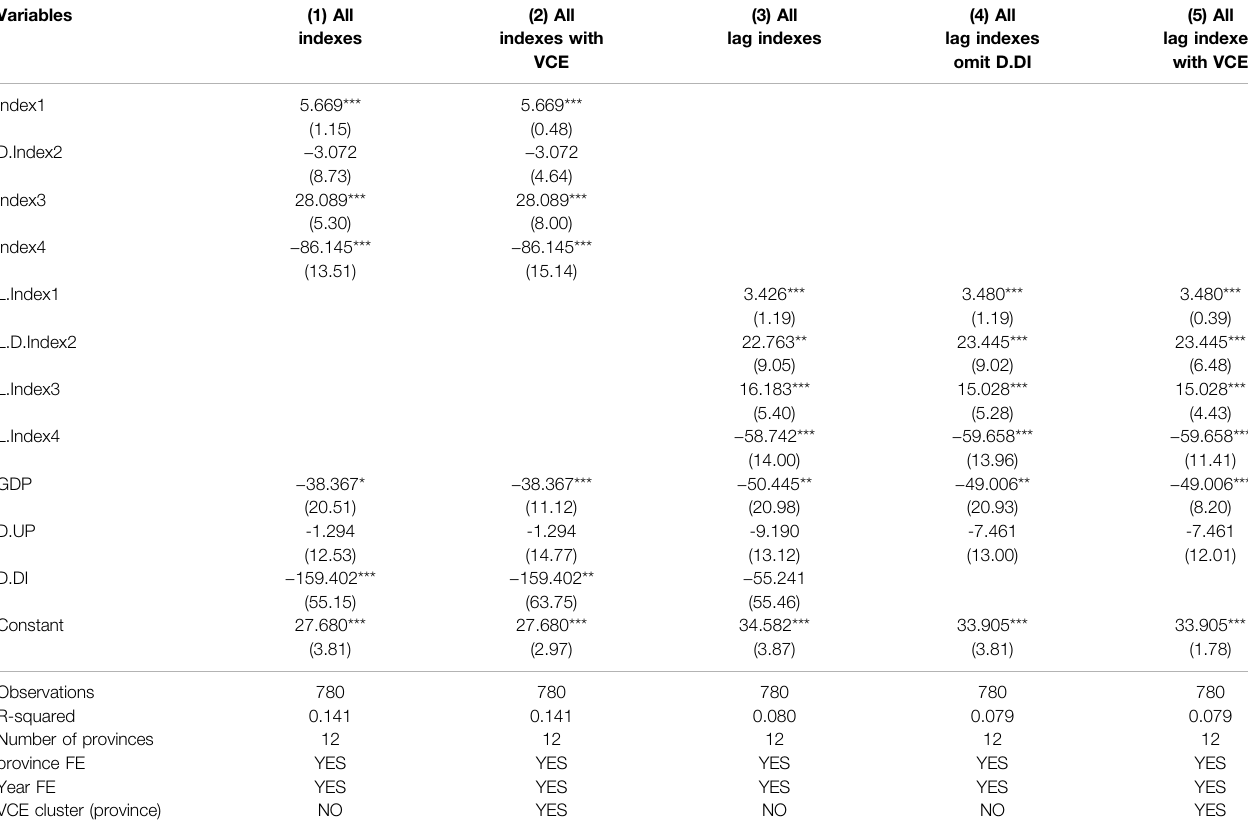
TABLE 8 | Model estimation results using Baidu search index regarding the west district of China.